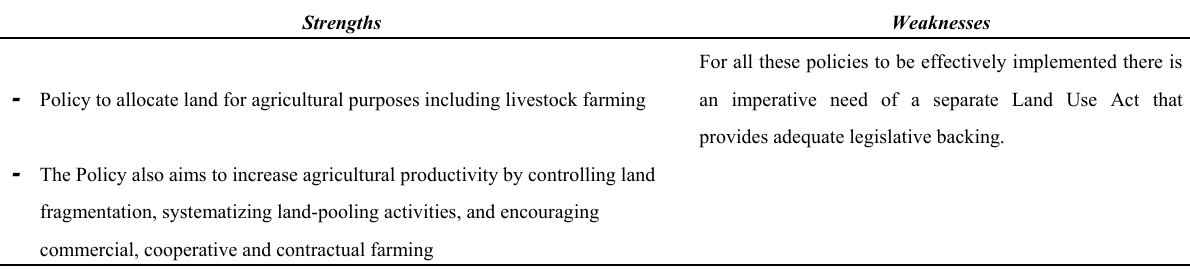
Table 5. SWOT Analysis of National Land Use